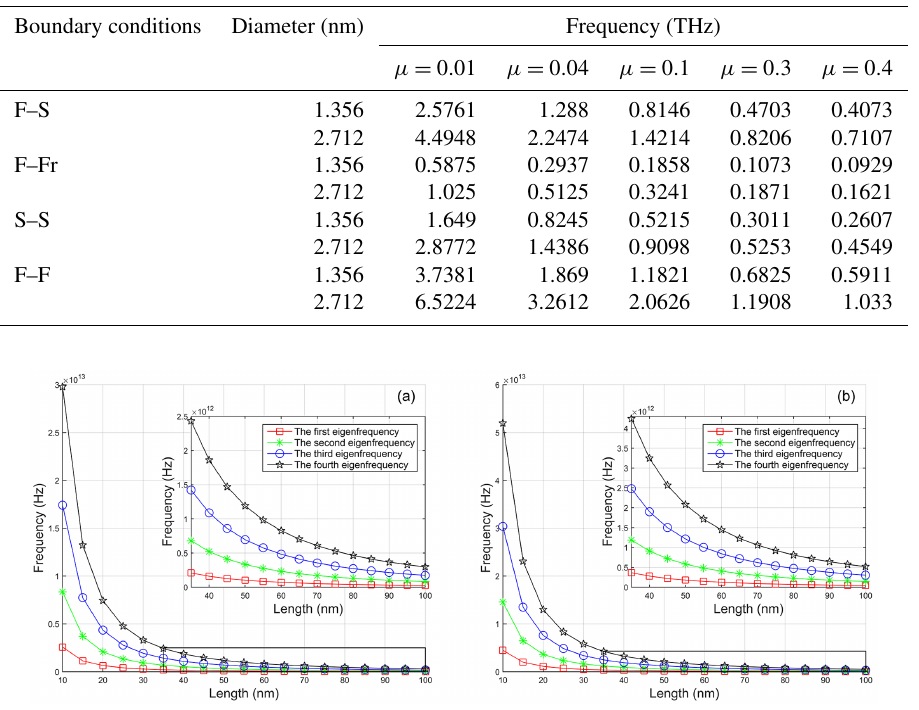
Table 4. The first eigenfrequencies of armchair nanotubes with length L = 10nm for different boundary conditions and nonlocal parameters µ .